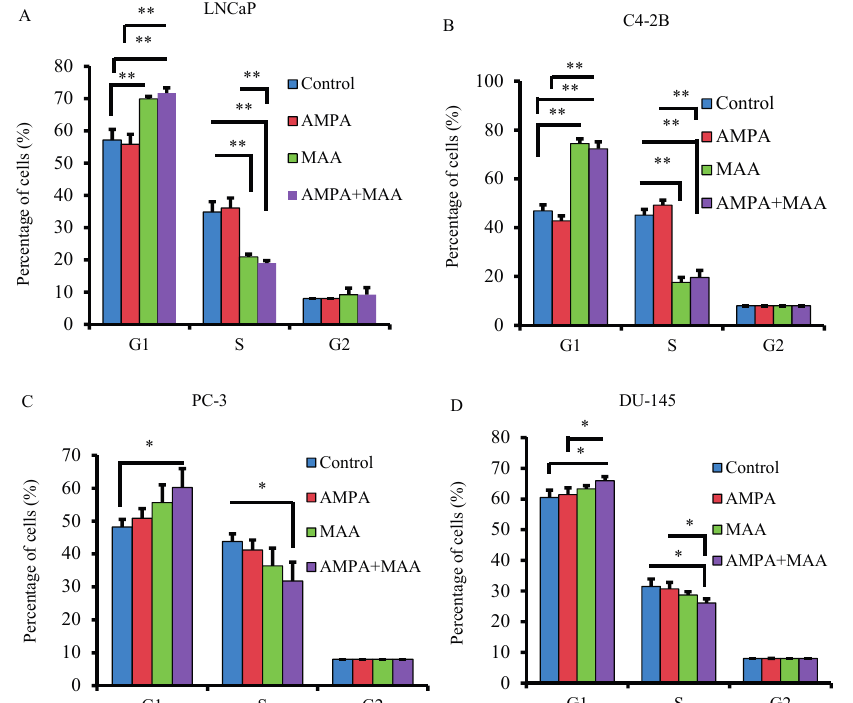
Figure 3. AMPA and MAA block the G1/S transition of the prostate cancer cell